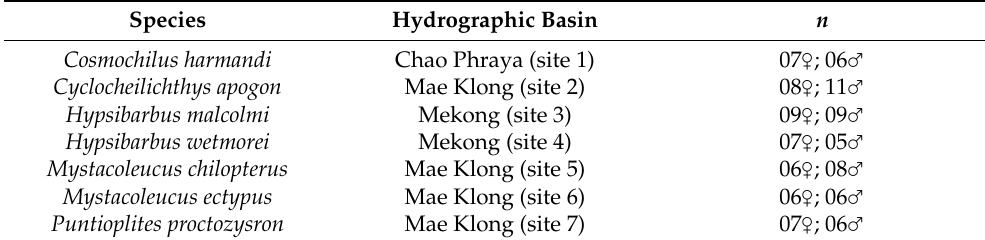
Figure 1. Thailand map showing the collection sites of the seven species studied including 1. Cos- mochilus harmandi (light green circles); 2. Cyclocheilichthys apogon (yellow circles); 3. Hypsibarbus malcolmi (orange circles); 4. Hypsibarbus wetmorei (dark green circles); 5. Mystacoleucus chilopterus (red circles); 6. Mystacoleucus ectypus (blue circles); 7. Puntioplites proctozystron (pink circles). Scale bars = 1 cm (fish), 200 km (map) or 150 miles (map). Table 2. The collection sites of the seven ‘poropuntiinae’ species and number of analyzed individuals (n).